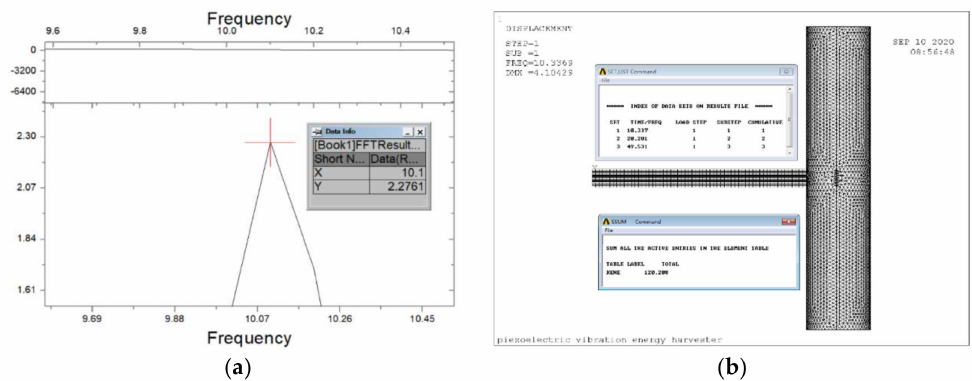
Figure 4. ( a ) FFT (Fast Fourier Transform) to get the natural frequency; ( b ) ANSYS APDL modal analysis.